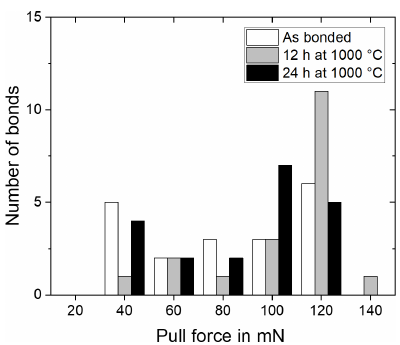
Figure 11. Bond strength distribution on a platinum thick film layer on sapphire, as bonded and after the thermal ageing of the bond on thick film for 12h at 1000 ◦ C and 24h 1000 ◦